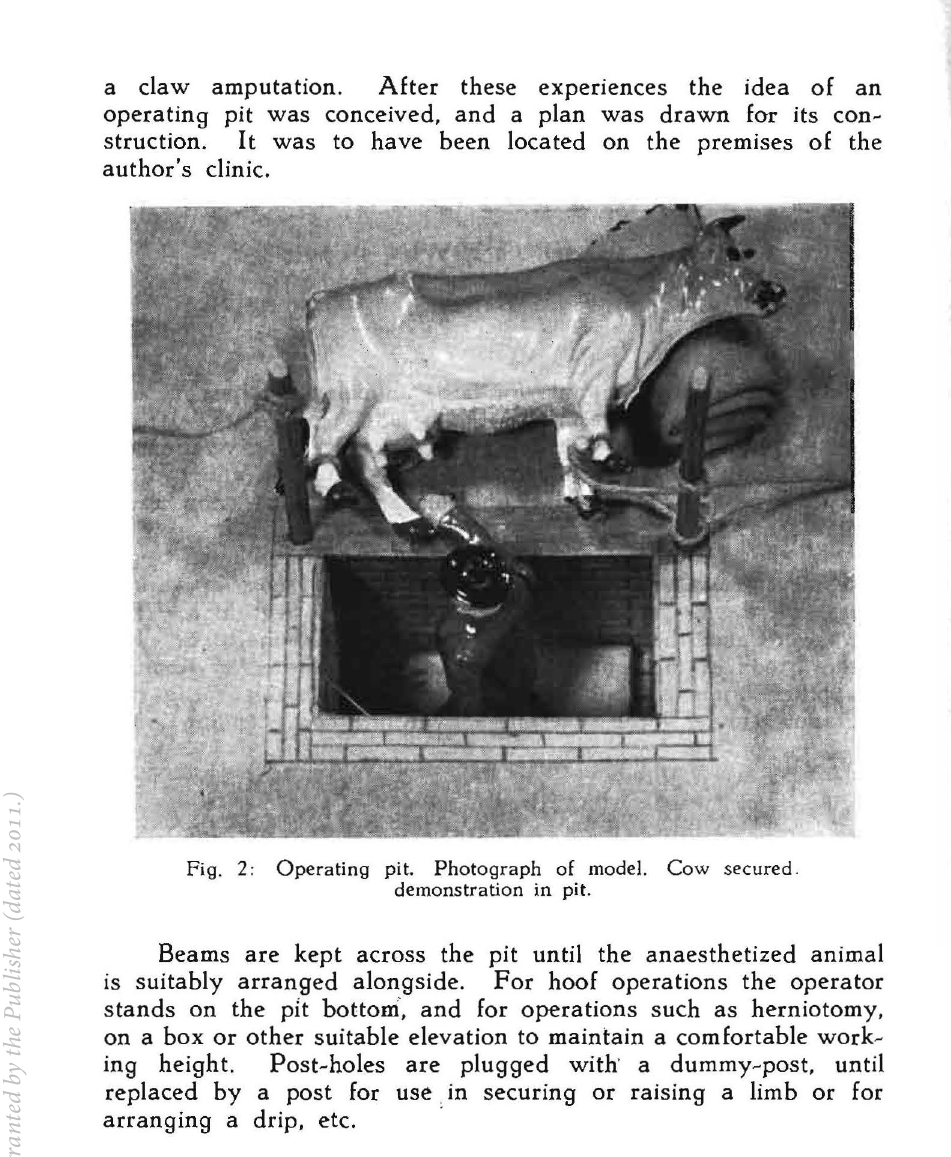
Fig. 2: Operating pit. Photograph of model. Cow secured. demonstration in pit. Beams are kept across the pit until the anaesthetized animal is suitably arranged